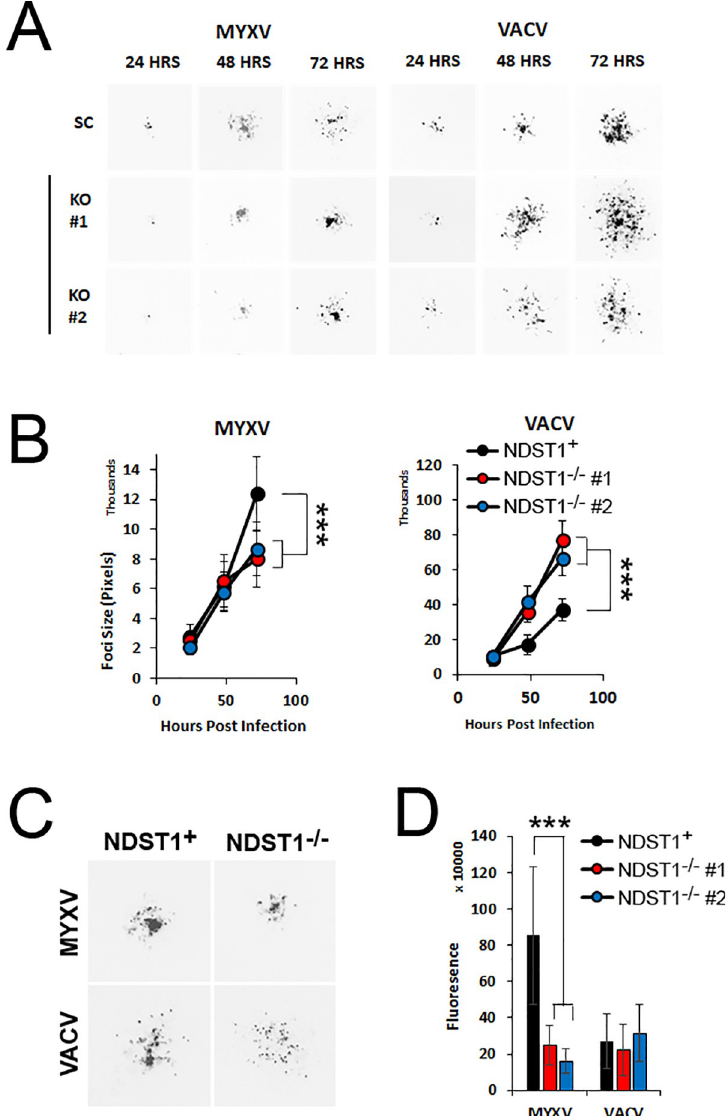
Fig 5. Binding affinity has inverse impacts on the spread of different poxviruses. (A) Images of individual GFP + foci formed in either NDST1 + or deficient cells taken 24, 48, or 72 hours post infection with the indicated virus. (B) Quantitation of individual foci size. Data shown is representative of four independent experiments, where a total of > 60 foci per cell/virus type were measured. (C) Up-close image of foci showing the different concentration of infected cells in the core. (D) Quantitation of total GFP signal in individual foci from experiments above. Data shown represents average GFP expression from > 15 foci measured across three experiments. Statistical significance was determined using Students T-Test ( ��� = p <